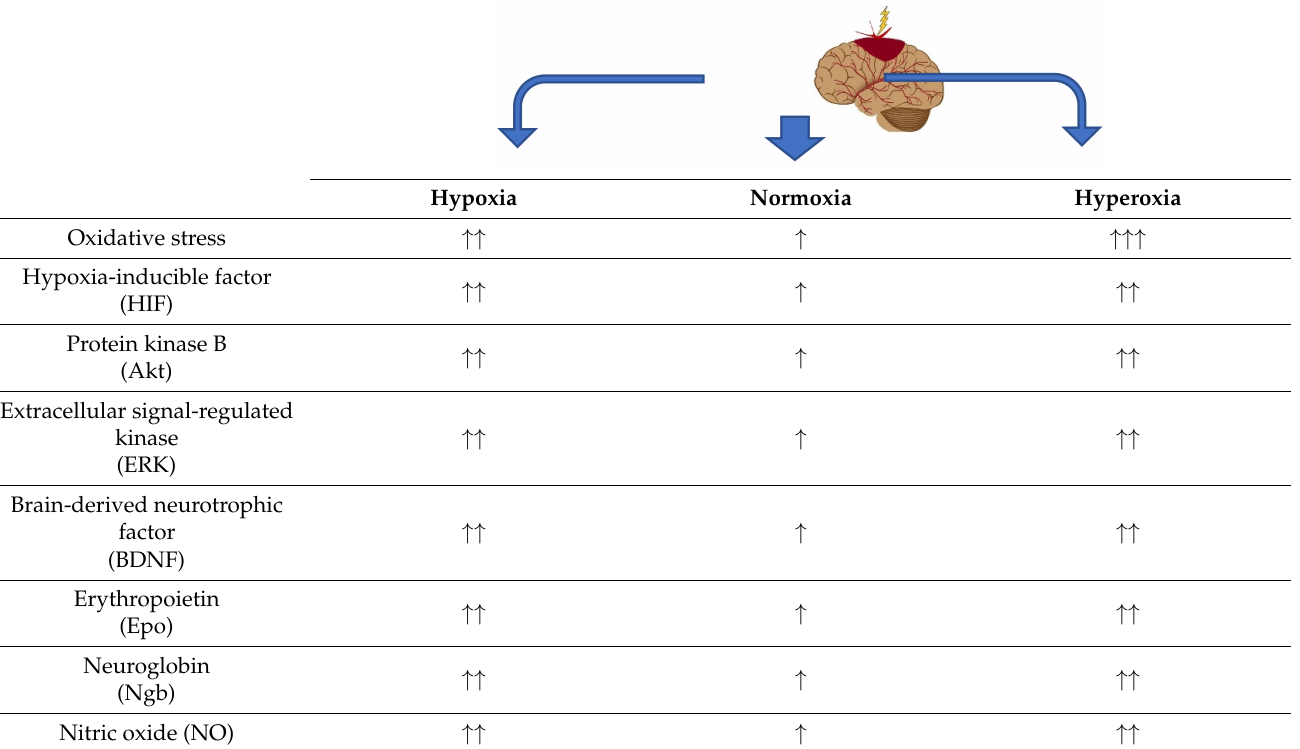
Table 1. Potentially effect of disorders in oxygen delivery to the brain on selected pathways and factors. Up arrows indicate the direction of the mechanism that may be intensified to varying degrees, depending on the causative factor. The number of arrows defines the intensity of the processes.